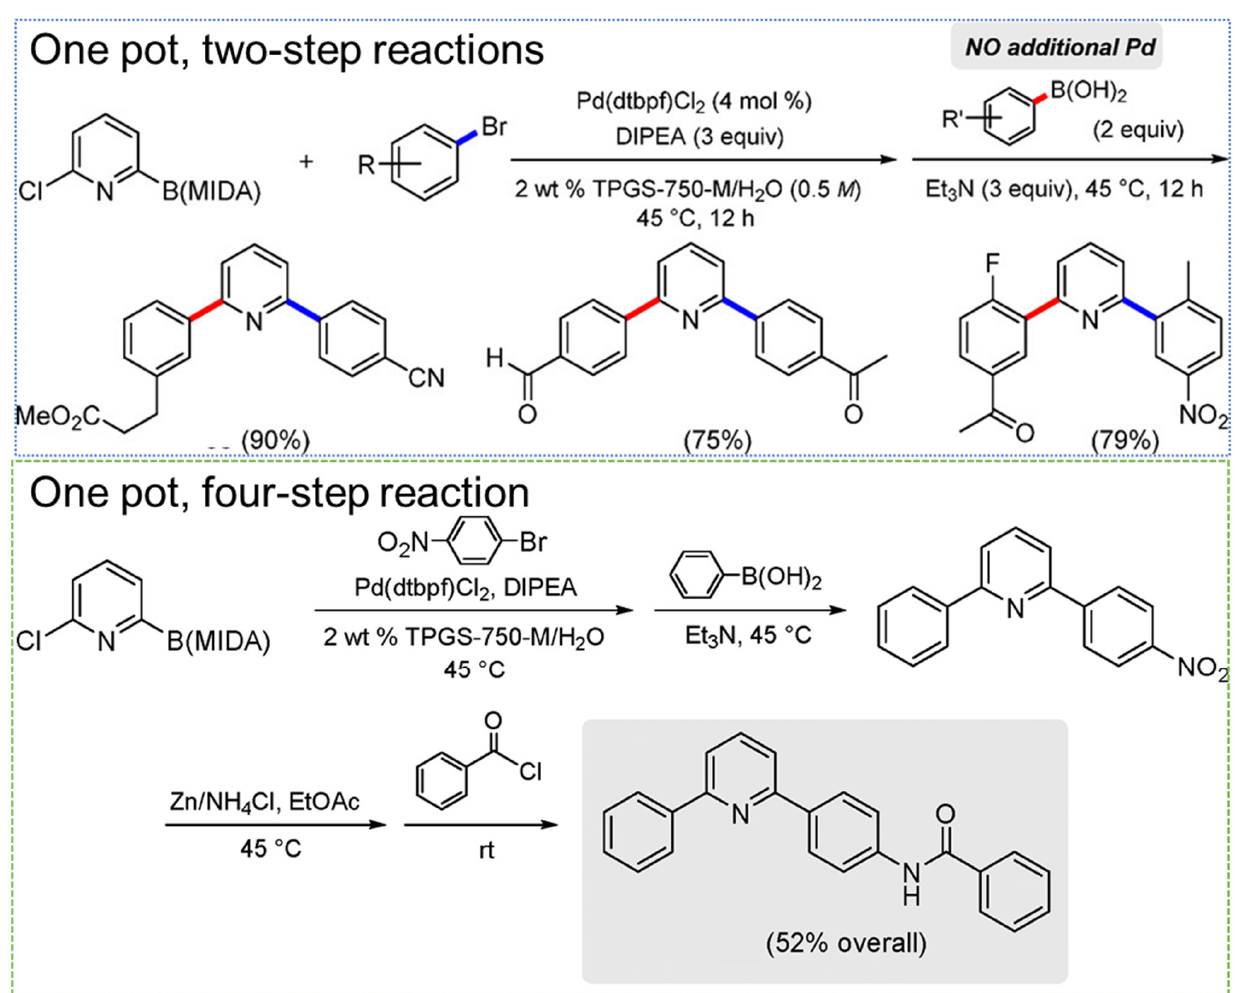
Figure 7. One-pot, two-step reactions to access to 2,6-disubstituted pyridines using micellar catalysis and Pd-catalyzed Suzuki–Miyaura cross-coupling reactions. Red and blue indicated bond formation in separate reaction steps. One-pot, four-step reaction to produce a drug analogue for Hedgehog sig- naling antagonist. Products were isolated by extraction with ethyl acetate and flash